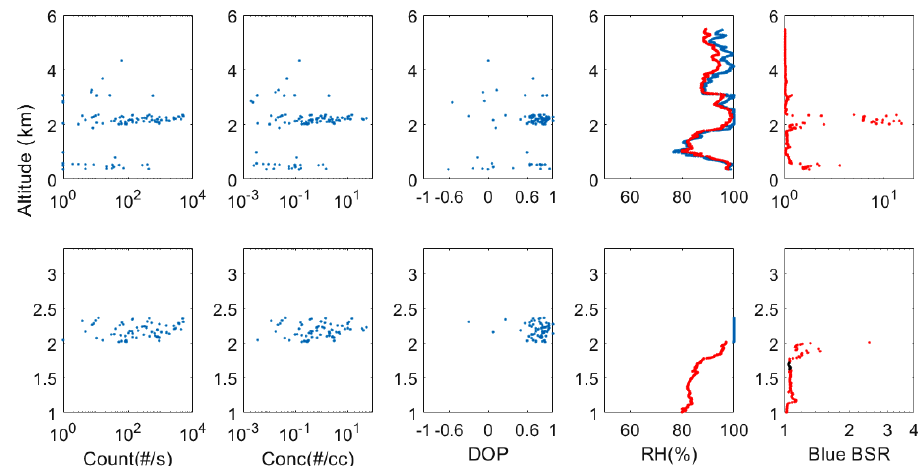
Figure 5. The top row shows COBALD (red dots) and CPS (blue dots) observations from a sounding held on 1 November 2018 up to the altitude of 6km (as the focus is on the liquid cloud region). The bottom row shows the same parameters but for the portion of the same profile where liquid cloud (blue dots) and aerosol (from cloud base to 500m below) were identified by the scheme.